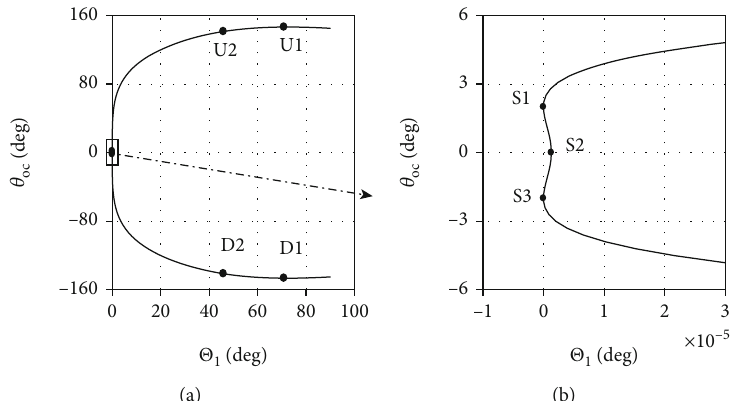
Figure 5: Bifurcation curve of the 3D SS landing gear ((b) presents an enlarged view of the rectangular frame in